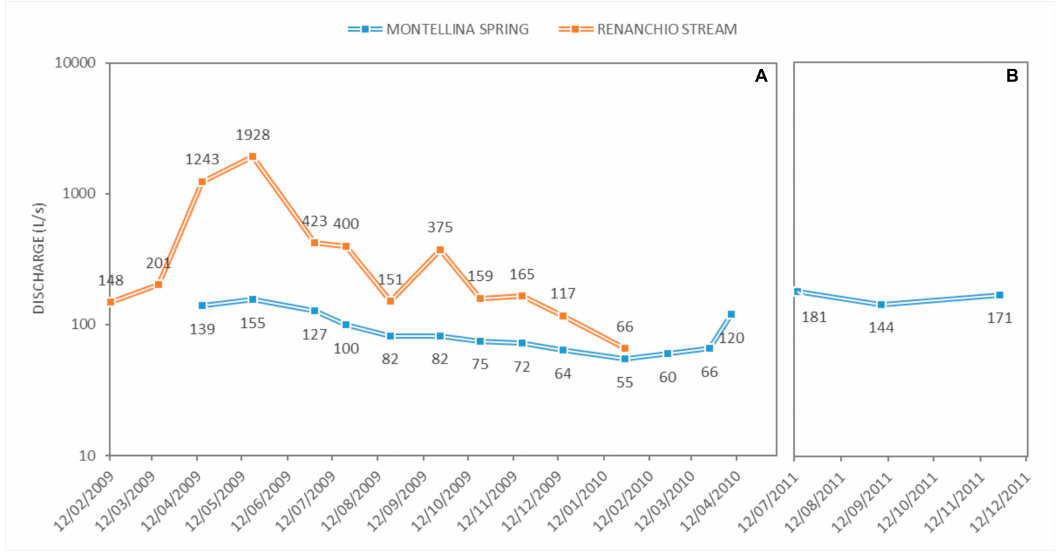
Figure 2. Montellina Spring and Renanchio Stream discharge (( A ): modified from [15]; ( B ): modified from [16]).